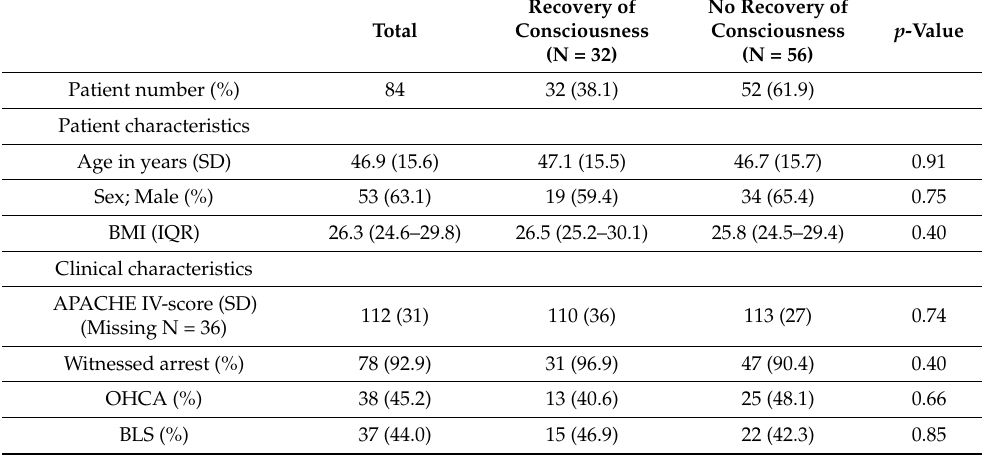
Table 1. Characteristics of extracorporeal cardiopulmonary resuscitation (ECPR) patients for patients who did and did not experience a recovery of